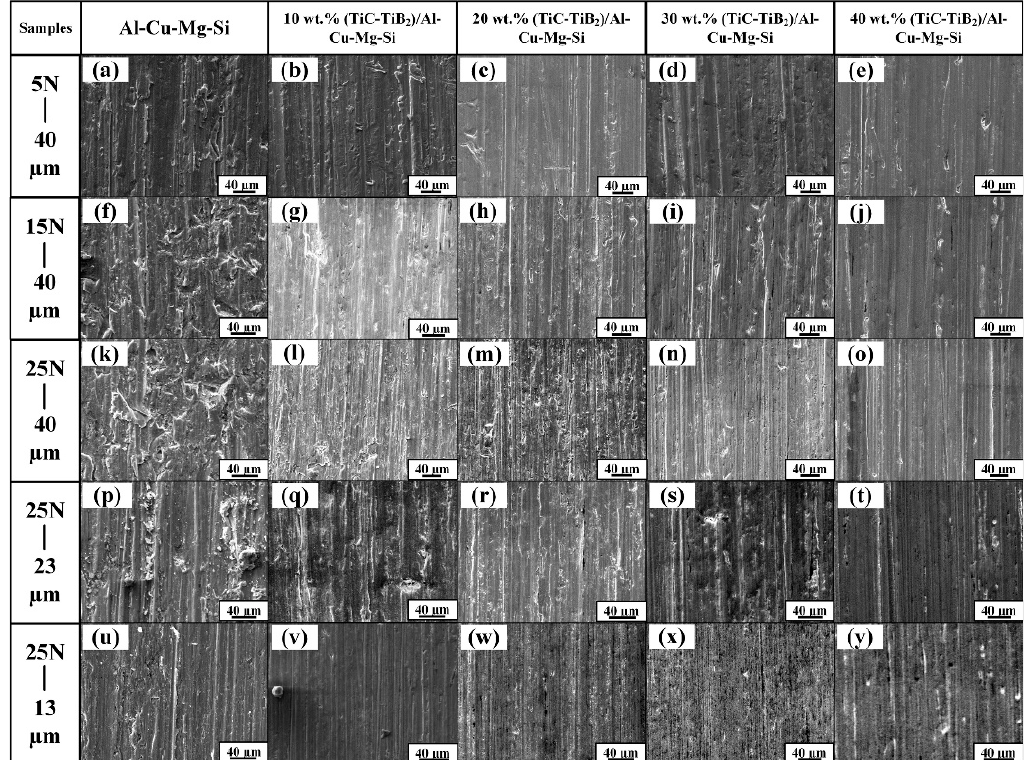
Figure 9. Worn surfaces of Al-4.7Cu-0.32Mg-0.44Si alloy and (TiC-TiB 2 )/Al-4.7Cu-0.32Mg-0.44Si composites tested under various loads and Al 2 O 3 abrasive sizes. ( a ) Al-4.7Cu-0.32Mg-0.44Si alloy,